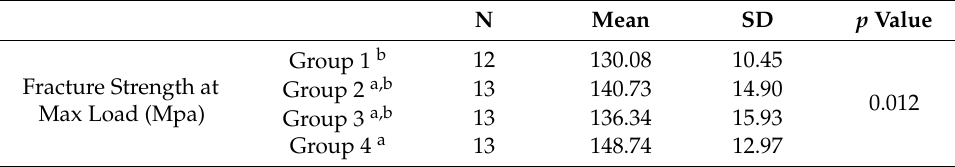
Table 1. Comparison of the Mean Fracture Strength at Maximum Load between the groups.